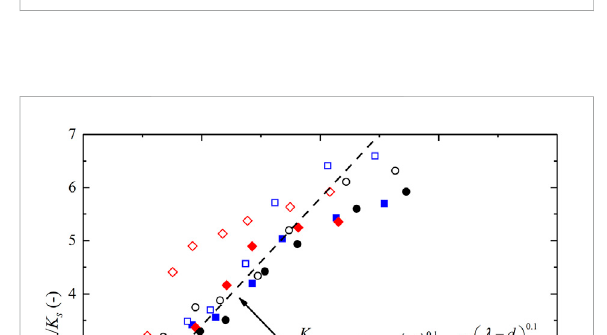
FIGURE 12 K r / K s versus e + , Re from 5 × 10 3 to 10 5